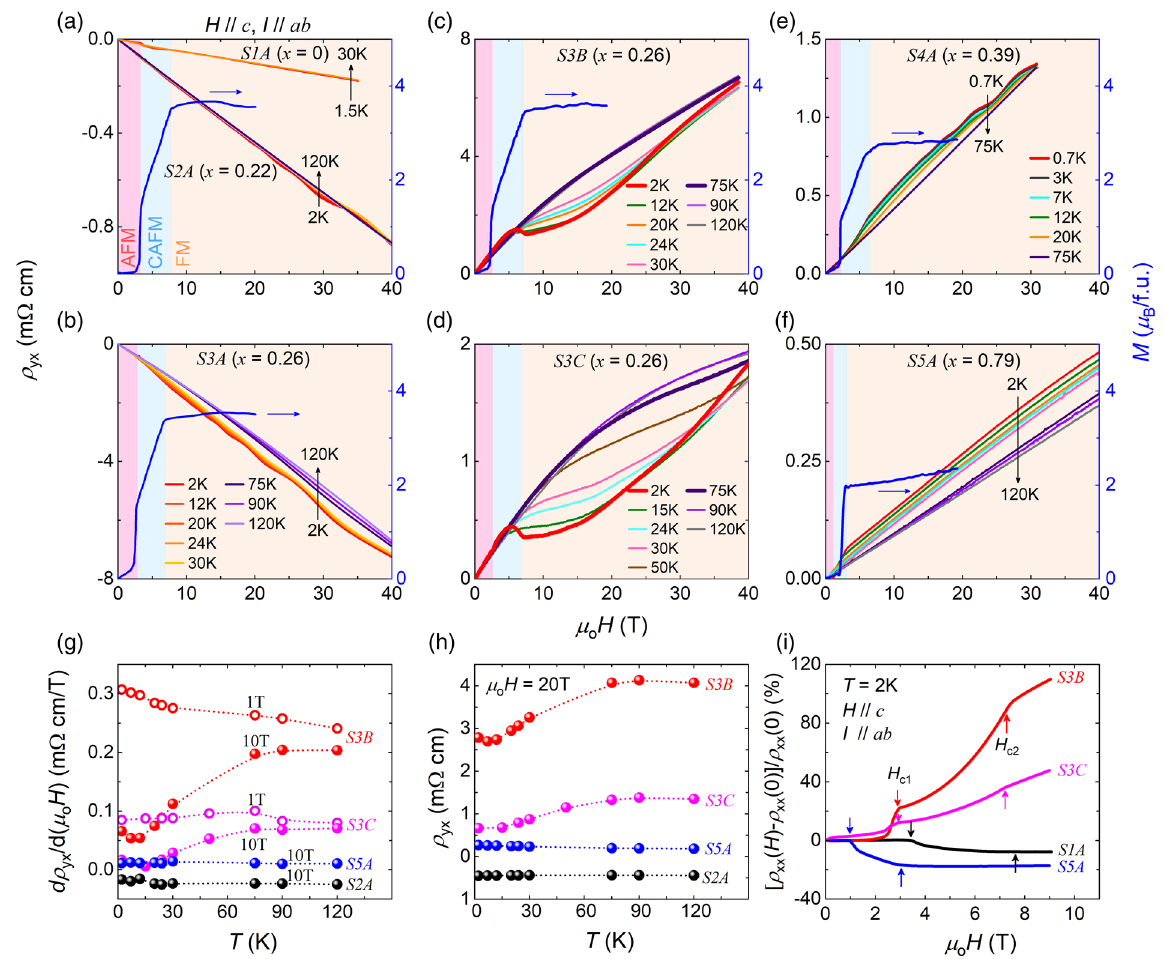
FIG. 1. Magnetic and transport properties of Mn ð Bi 1 − x Sb x Þ 2 Te 4 . Magnetic field dependence of Hall resistivity ρ yx at various temperatures and magnetization M at 2 K for Mn ð Bi 1 − x Sb x Þ 2 Te 4 with (a) x ¼ 0 and 0.22, (b) – (d) 0.26, (e) 0.39, and (f) 0.79. All these measurements are conducted with the currents applied along the ab plane and the magnetic fields perpendicular to the plane. The rose, blue, and orange regions refer to the AFM, CAFM, and FM phase regions, respectively, determined by magnetization [blue curves in (a) – (f)]. The heavily (a),(f) and moderately (e) doped samples exhibit linear magnetic field dependence for ρ yx or almost linear ρ yx background, while the lightly doped samples S3A , S3B , and S3C show nonlinear field dependence in ρ yx (b) – (d). The S3A , S3B , and S3C samples used in this study are taken from the same growth batch but display either electronlike (b) or holelike (c),(d) transport behavior in ρ yx ð H Þ owing to inevitable chemical inhomogeneity as discussed in the text. (g) Temperature dependences of the Hall resistivity slope d ρ =d ð μ H Þ at 1 and 10 T for the lightly hole-doped ( S3B , S3C ), heavily electron-doped ( S2A ), and heavily hole-doped ( S5A ) yx o